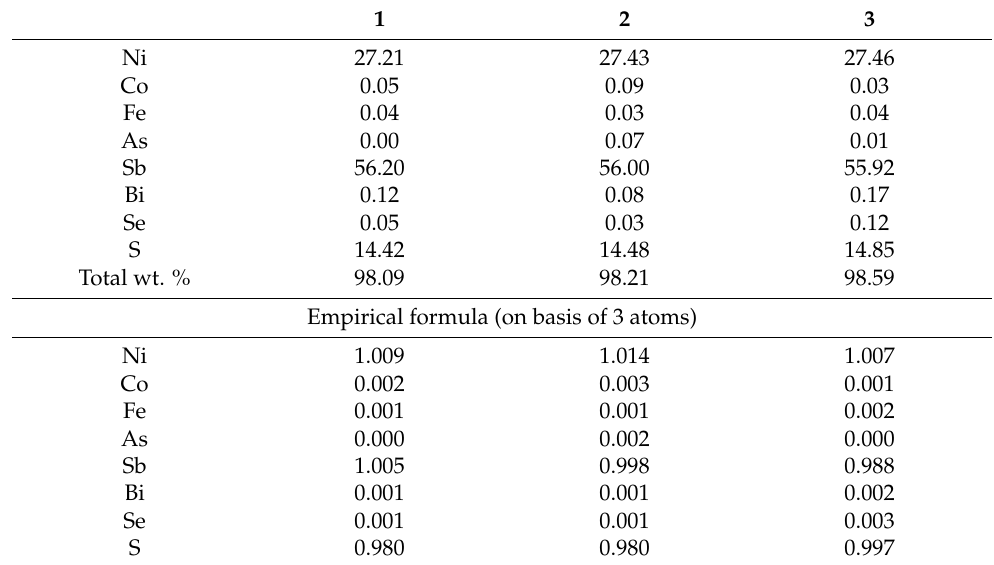
Table 5. Representative WDS microanalyses of ullmannite from ˇCuˇcma (Majersk á